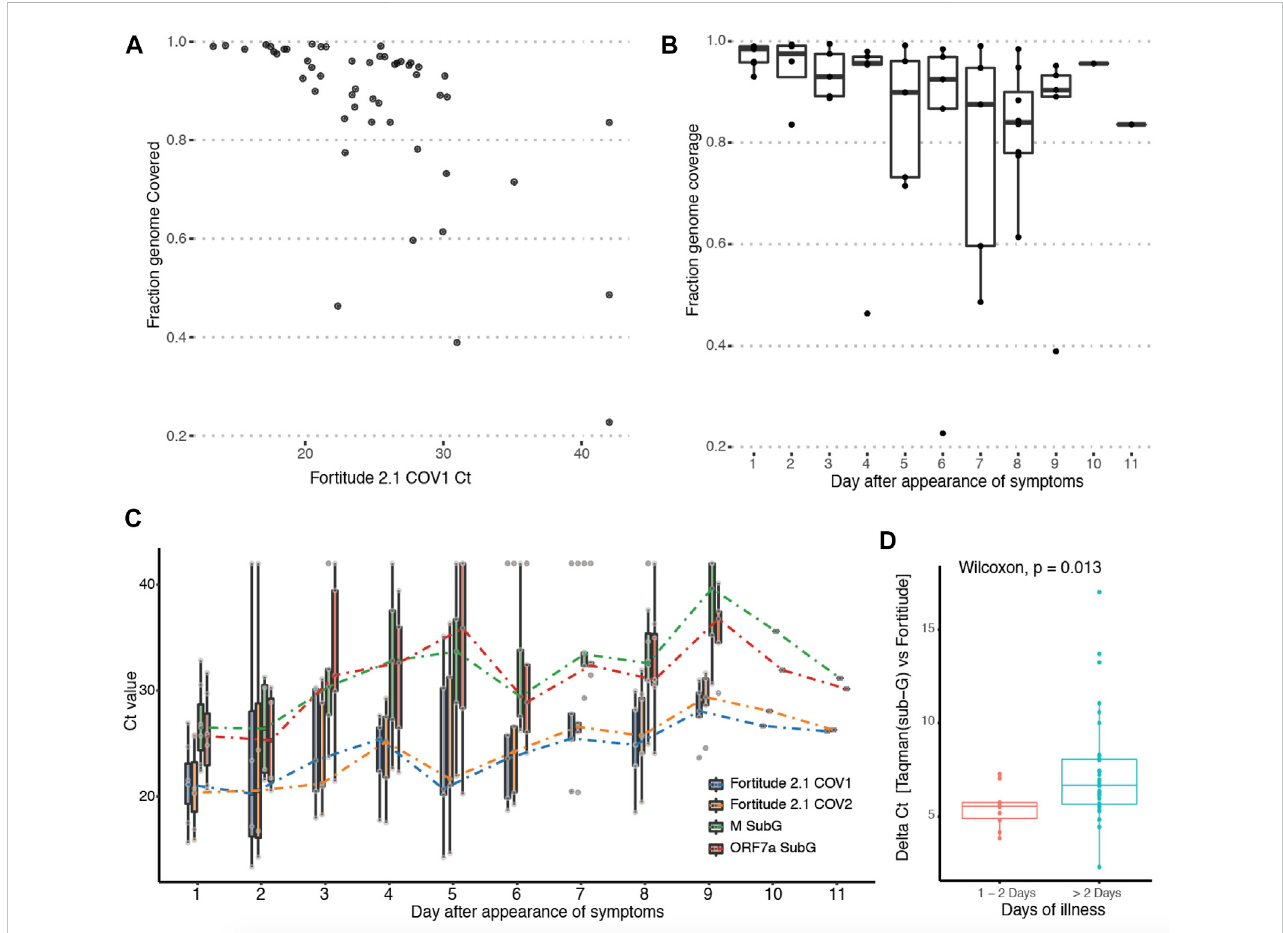
FIGURE 3 Tracking abundance of subgenomic transcripts across infection course. (A) Y-axis: Genome coverage by Arctic sequencing across 53 patients. X-axis: Ct-value of the Taqman assay targeting the genomic region of the SARS-Cov-2 genome from each patient. (B) Boxplot of genomic coverage by Arctic sequencing binned byday ofsymptom atwhich patient wassampled. (C) BoxplotofTaqman quantitation Ctvaluesusing primers targeting genomic-speci fi c RNA (Fortitude 2.1 COV1 and COV2) and subgenomic-speci fi c RNA (3a SubG, 7a SubG) binned by day of symptom at which patient was sampled. (D) Wilcoxon rank sum test with continuity correction was performed on samples binned by early (day 1 and 2) and latter stages (day 3 – 11) of